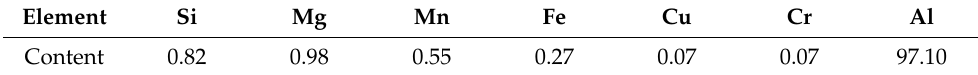
Table 1. Chemical composition of the investigated aluminum alloy EN AW-6082 in wt.%.